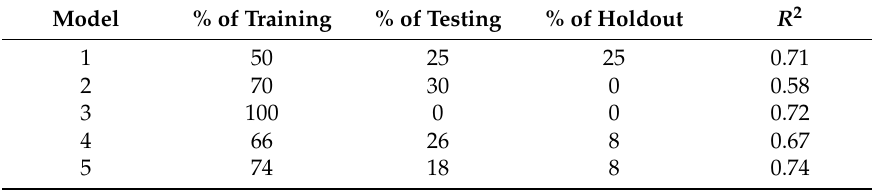
Table 2. Determination of the optimal data repartition in artificial neural network (ANN) modeling. Model